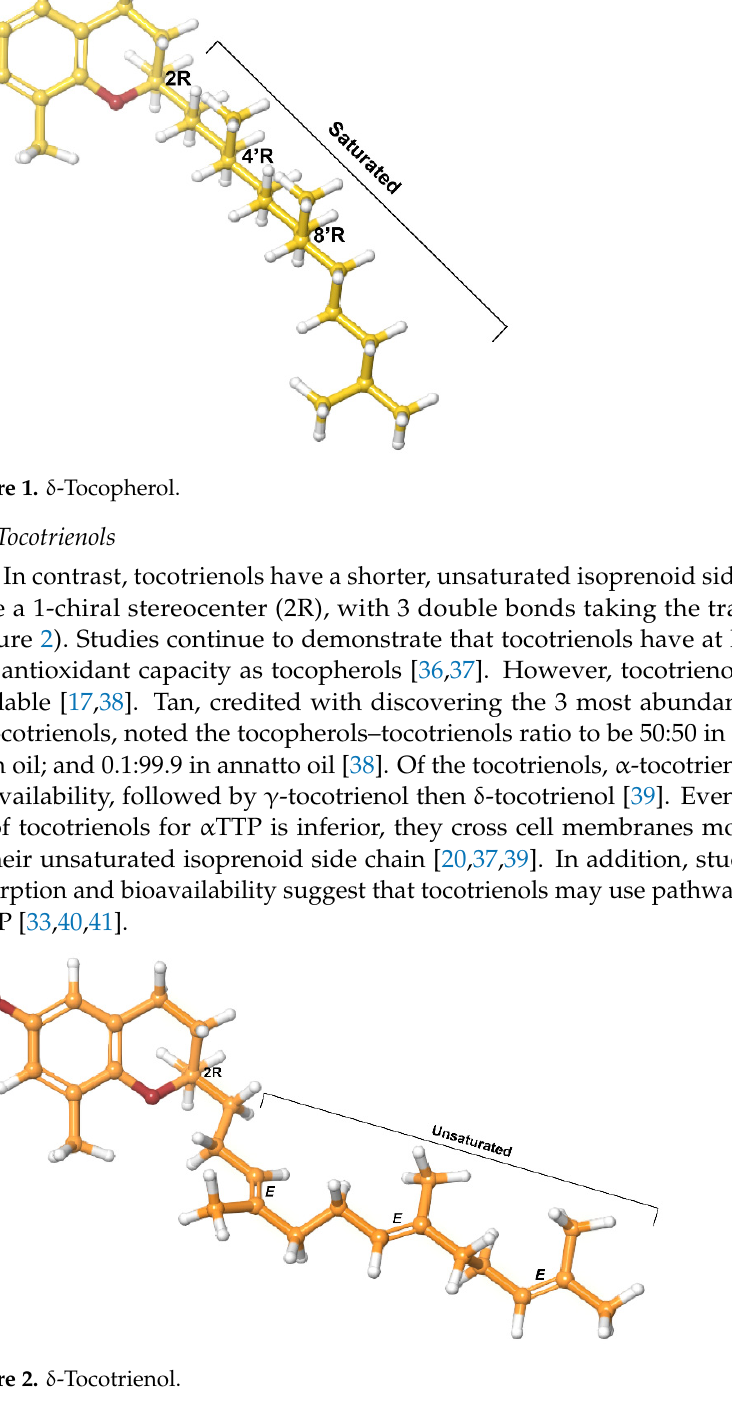
Figure 2. δ Figure 2. δ -Tocotrienol.